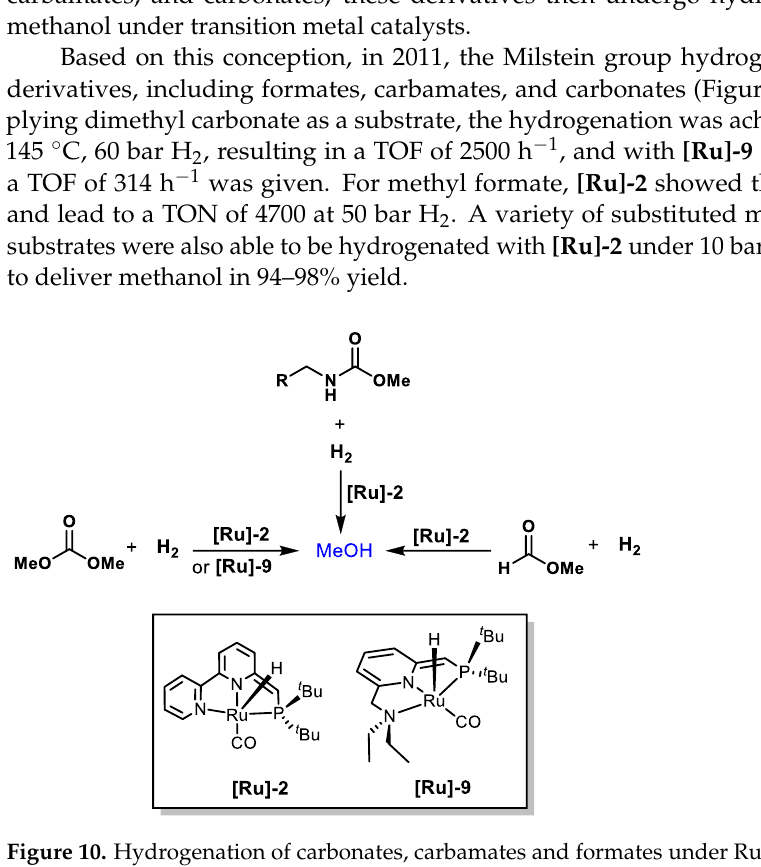
Figure 10. Hydrogenation of carbonates, carbamates and formates under Ru catalysis.